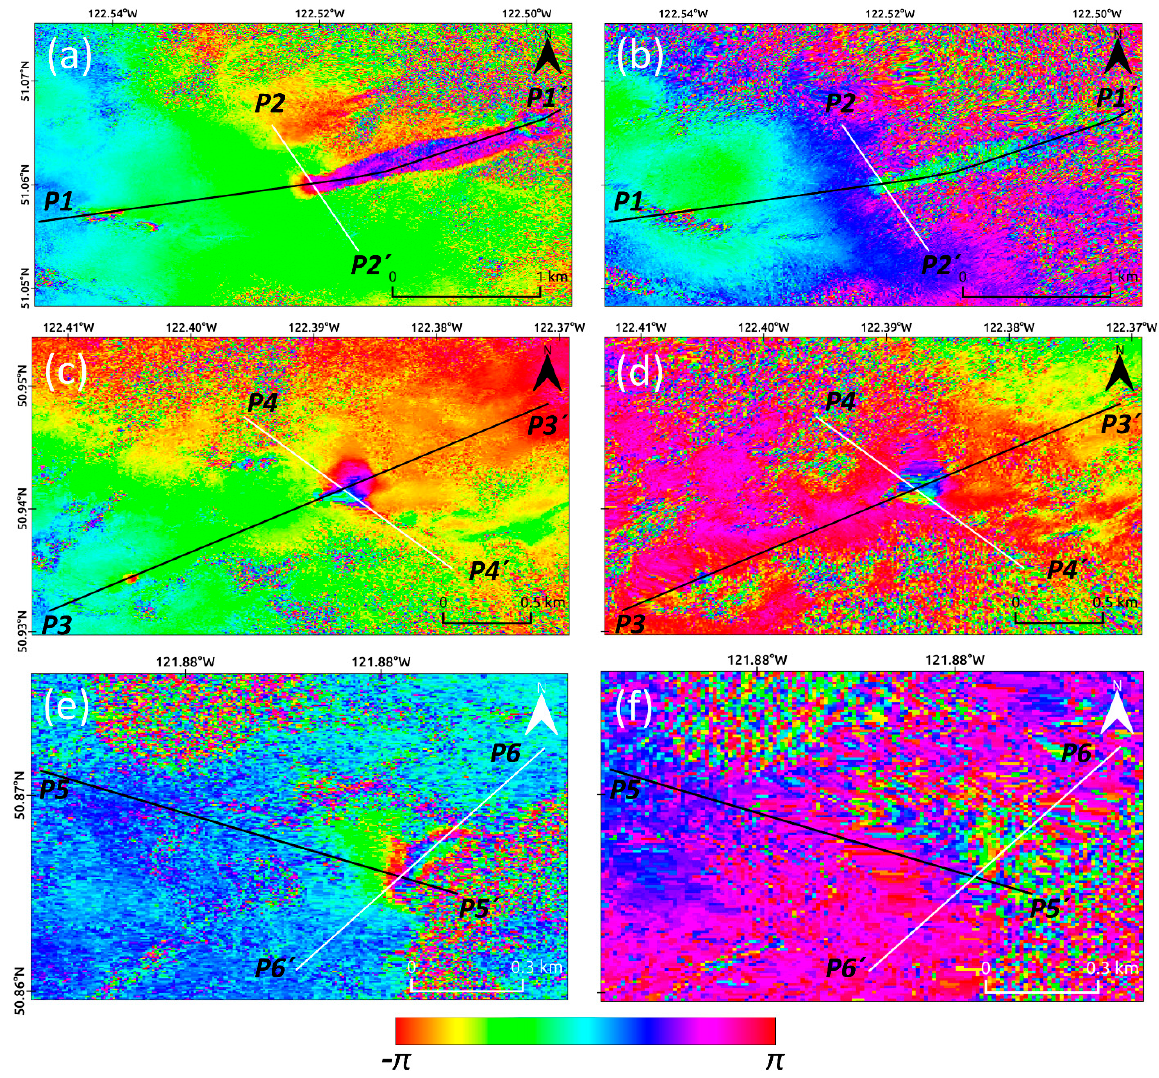
Figure 7. DInSAR interferograms of Sites 5 ( top ), 6 ( middle ), and 9 ( bottom ) generated from the RCM 26 June 2020–6 September 2020 pair ( a , c , e ) and Sentinel-1 18 June 2020–22 September 2020 pair ( b , d , f ). The black lines represent west-east displacement profiles and the white lines represent north-south displacement profiles represented in Figures 8–10, respectively. The Sentinel-1 and RCM DInSAR interferogram maps are provided in the Supplementary Materials.